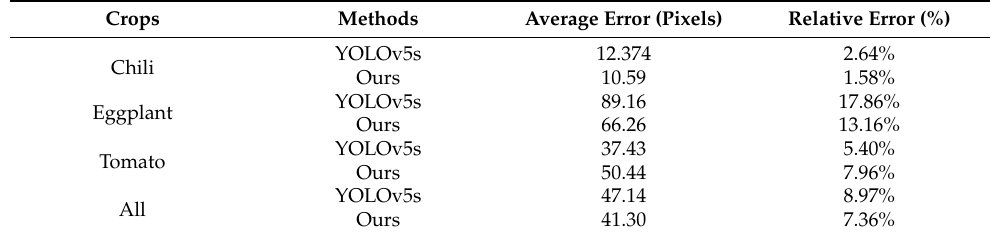
Table 6. Comparison of the results in the three categories of